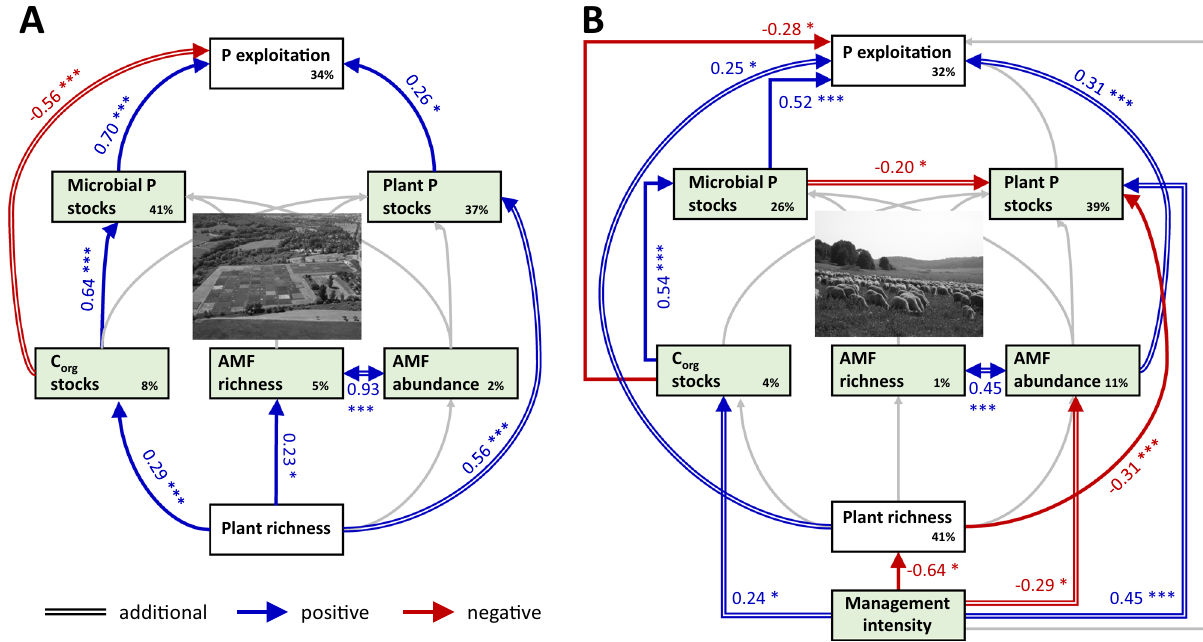
Fig. 1 Role of biodiversity for the P cycle. Panel ( A ) refers to the biodiversity experiment and Panel ( B ) shows the agricultural grasslands. Biodiversity comprises plant and AMF (arbuscular mycorrhizal fungi) species richness. In the structural equation model (SEM), blue and red arrows display relationships with positive and negative slopes, respectively. Grey arrows indicate non-signi fi cant relationships. Solid lines of arrows refer to relationships expected according to the hypotheses (Table 1), whereas parallel lines of arrows indicate paths that were included in addition (selection procedure described in Methods). Round-shaped paths refer to the (driving) role of biodiversity while square paths indicate the role of management. Numbers on arrows indicate standardised path coef fi cients. Percentages in boxes give the explained variance. * p < 0.05, ** p < 0.01, *** p < 0.001. The SEMs matched with the data: ( A ) Fisher ’ s C = 7.12, p = 0.93, df = 14; ( B ) Fisher ’ s C = 12.17, p = 0.43, df = 12. C org = organic carbon, P = phosphorus. Photo credits: The Jena Experiment ( A ), Jörg Hailer ( B